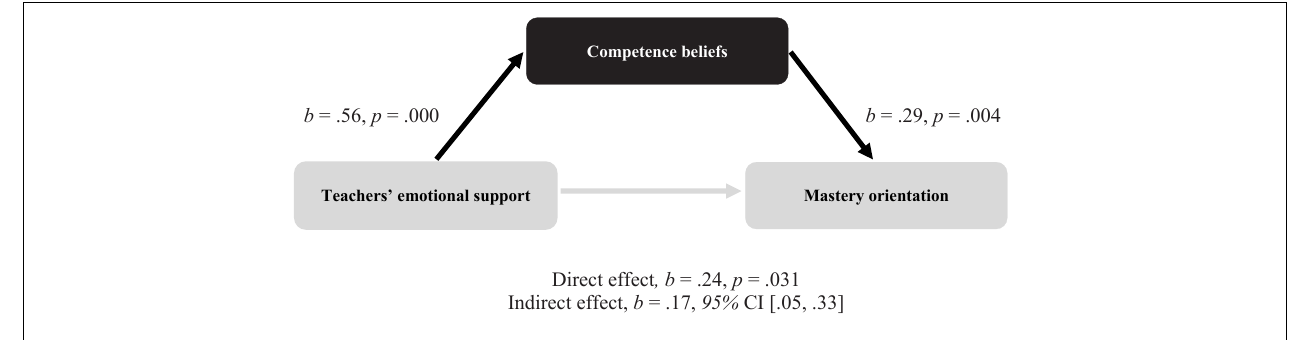
FIGURE 1 | Model of teachers’ emotional support as a predictor of mastery orientation, mediated by competence